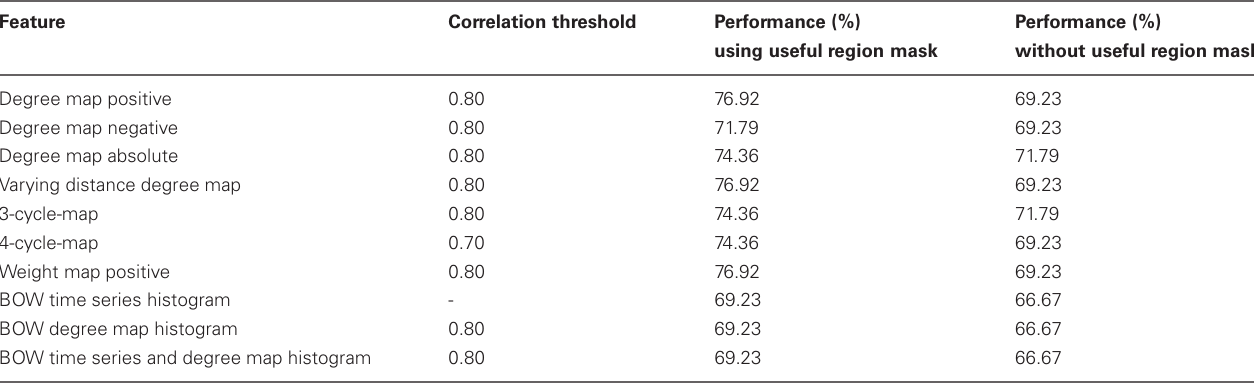
Table 3 | Initial test results shows the performance of all the network features computed on the Kennedy Krieger Institute’s data